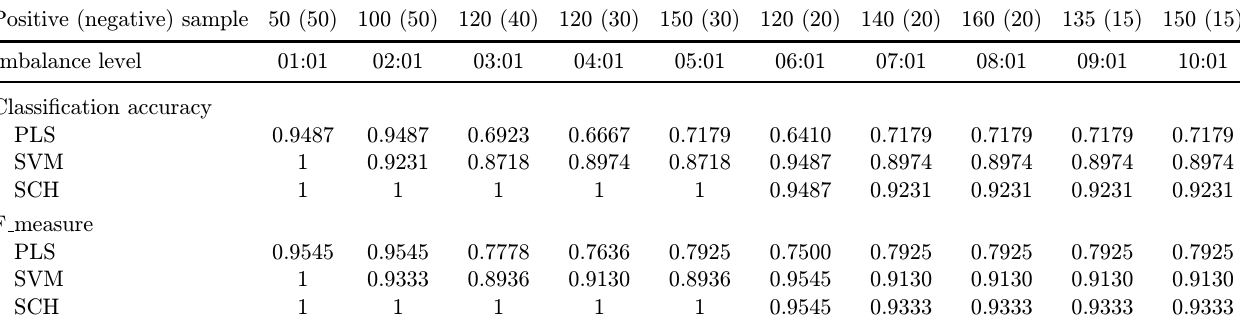
Table 4. Classi¯cation accuracy table for the imbalanced samples.